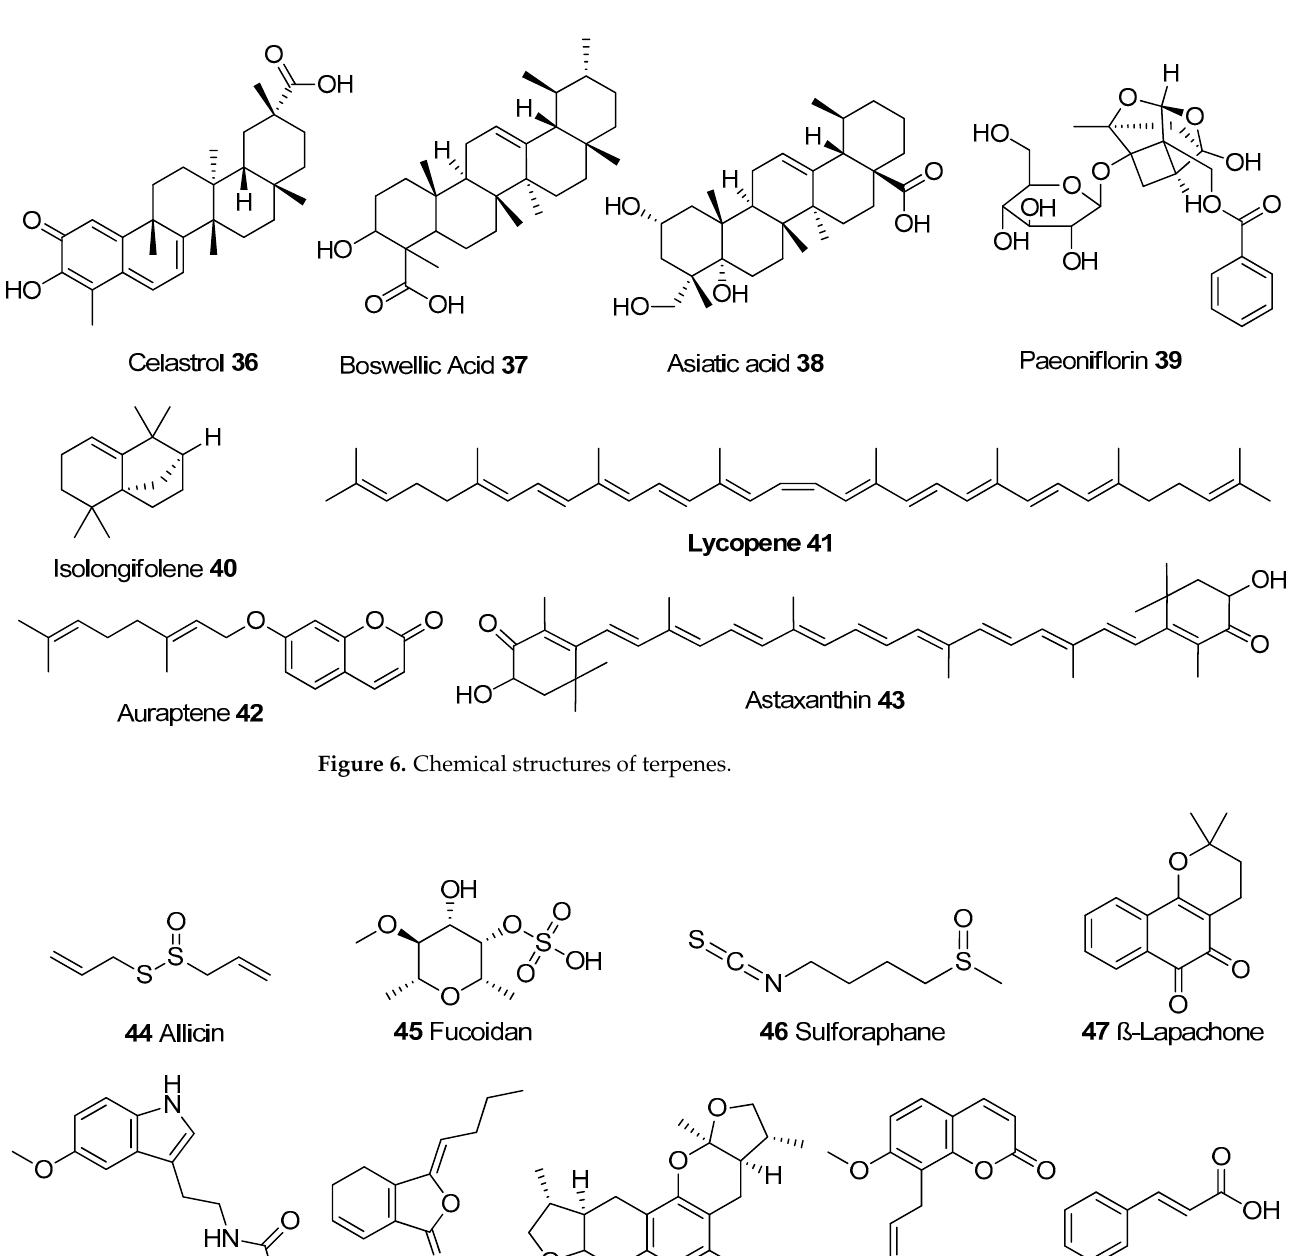
Figure 7. Other structural classes. Organosulphur compounds: 44-46; benzochromone: 47; Amine: 48; Lactone: 49; Cyclic polyketide: 50; Coumarin derivative: 51, Organic acid: 52.